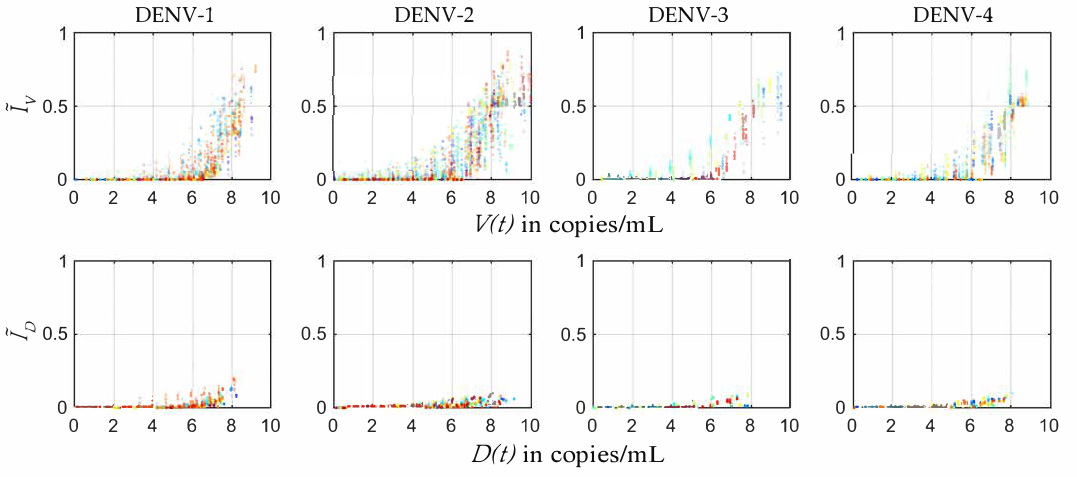
Figure 4. Mosquito infectious dose: The infected mosquitoes by virus (˜ I V ) and DI particles (˜ I D ) are shown in scattered plots with respect to the Log 10 values of corresponding within-host virus ( V ( t ) ) and DI particles ( D ( t ) ) levels. Different colours represent different patient models. These scatter plots represent the phase portrait of the data shown in Figure 2 versus the viraemia data reported in our previous model [32] and is a way to estimate the ranges of different mosquito infectious doses ( MID s), say MID 50